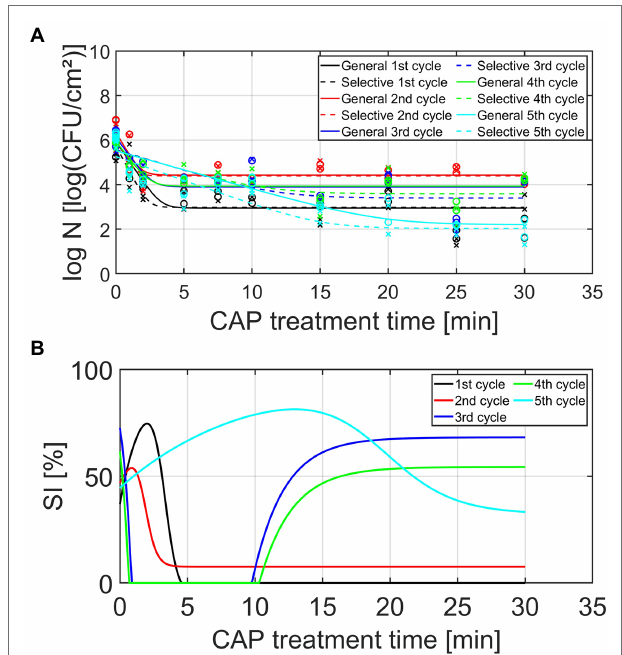
FIGURE 5 | (A) Cell density [log 10 (CFU/cm 2 )] and (B) percentage (%) of SI cells, both as function of the CAP treatment time for the Salmonella Typhimurium model biofilms ( n = 2). Five consecutive CAP treatment cycles were performed as: isolates from cycle × survivors were used to re-develop mature biofilms, which were again CAP treated (up to 30 min) in cycle x + 1. For the cell density, both the experimental data (symbols) and the global fit (line) of the Geeraerd et al. (2000) model are represented for each CAP treatment cycle: total viable population on non-selective medium (o, solid line) and uninjured viable population on selective medium (x, dashed line). For both the cell density and the percentage of SI, different CAP treatment cycles are indicated in different colors, i.e., black, red, blue, green, and light blue are used to illustrate the results obtained for the 1st, 2nd, 3rd, 4th, and 5th CAP treatment cycle,